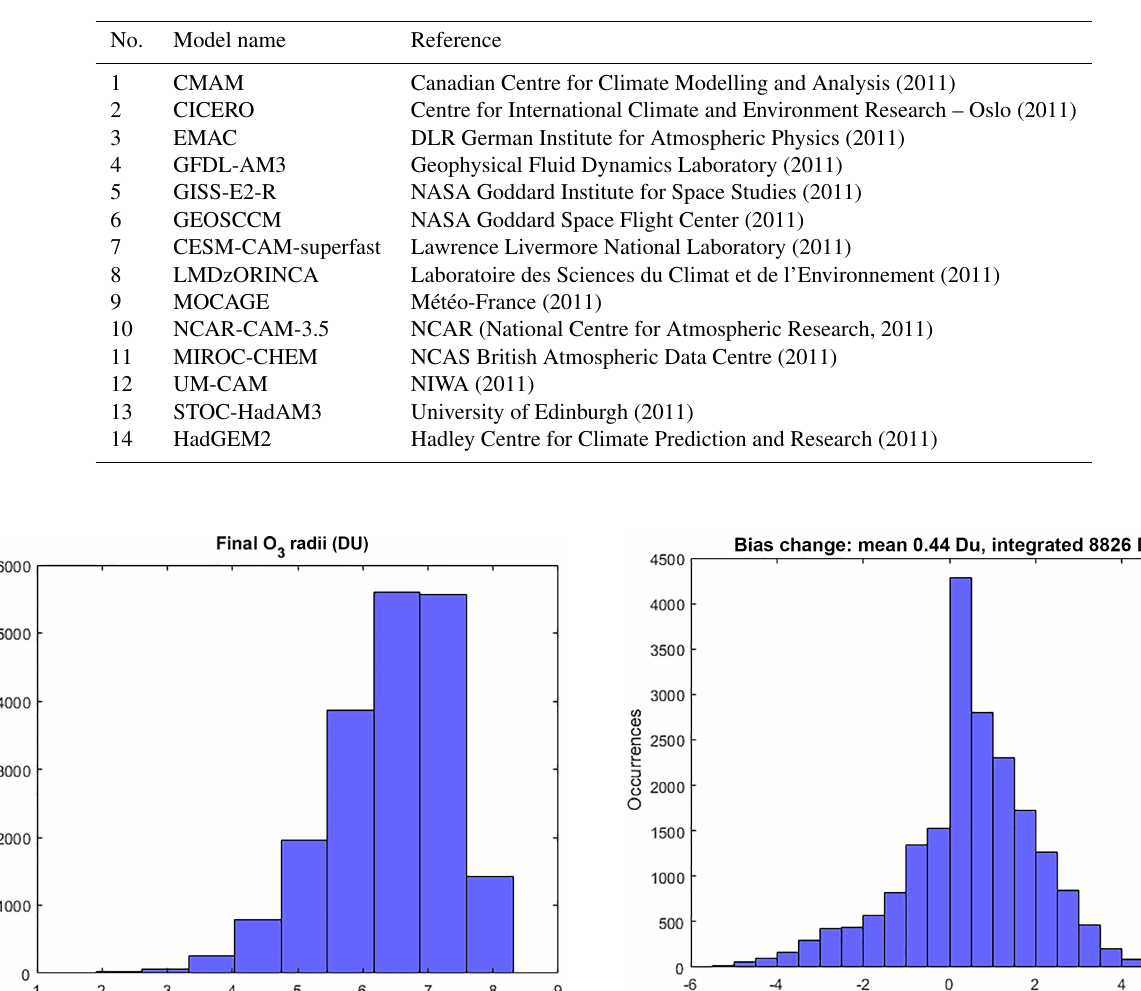
Table A1. Summary and citations for the ACCMIP models and data sets used in this work.